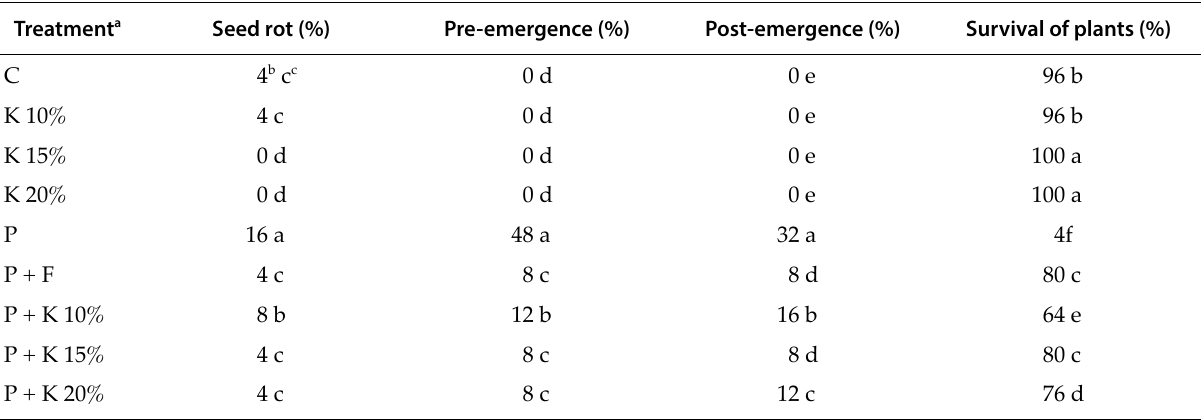
Table 6. Mean incidence of different expressions of Rhizoctonia root rot for maize plants treated with different concentra - tions of the khella methanol extract.** Treatment a Seed rot (%) Pre-emergence (%) Post-emergence